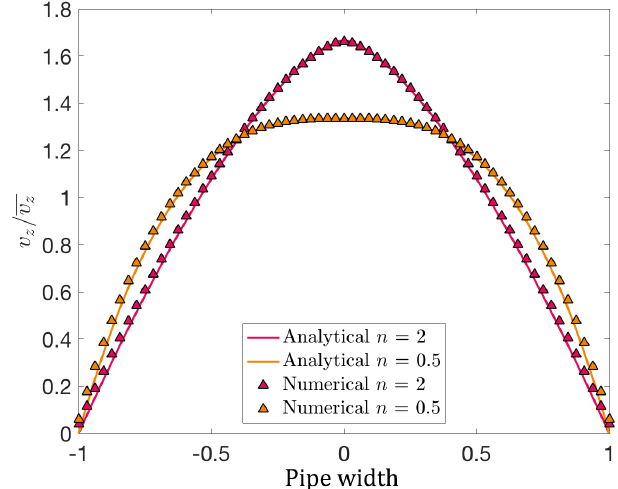
Figure 5. Computed || δ k || 2 norm of the misfit between analytically and numerically computed permeabilities. The inset shows the dis- cretization using four spheres in each direction (64 spheres in total). Streamlines are computed around those spheres and colorized with the computed velocity. Blue dots show results using stencil rescal- ing and red dots results with the standard method. To highlight con- vergence, black lines with given slopes were added.